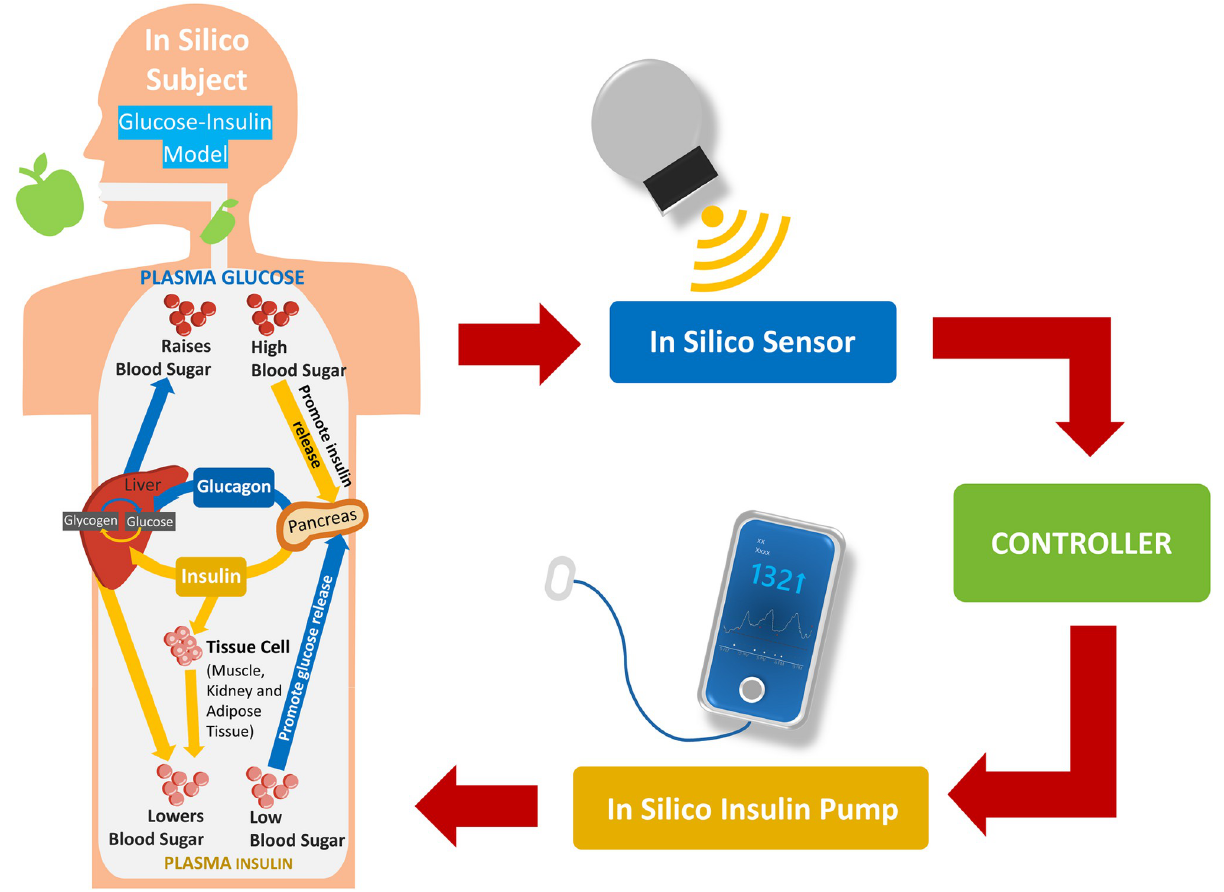
Fig 1. Principal components of the computer simulation